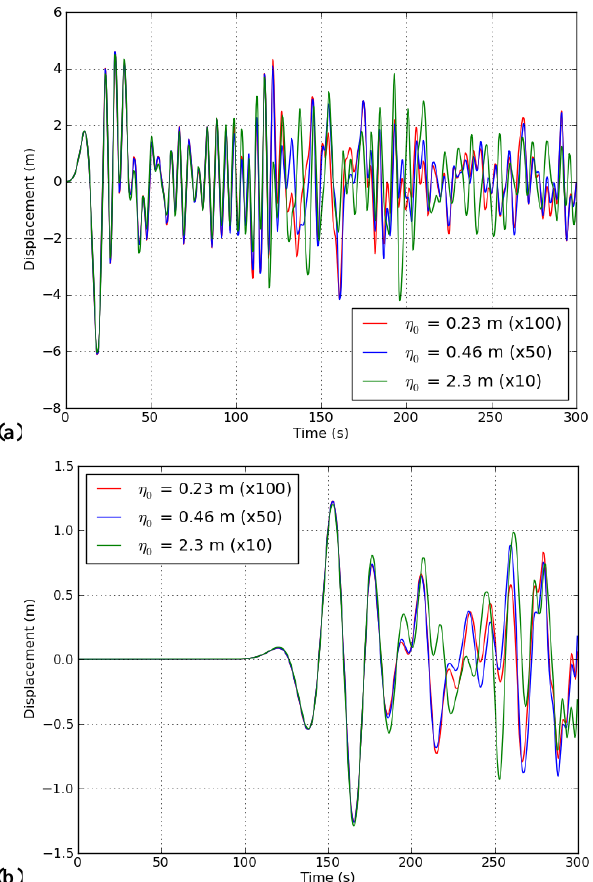
Fig. 8. Scatter diagram for measured and modeled wave runup. Fig. 7. Comparison between time series of surface displacement